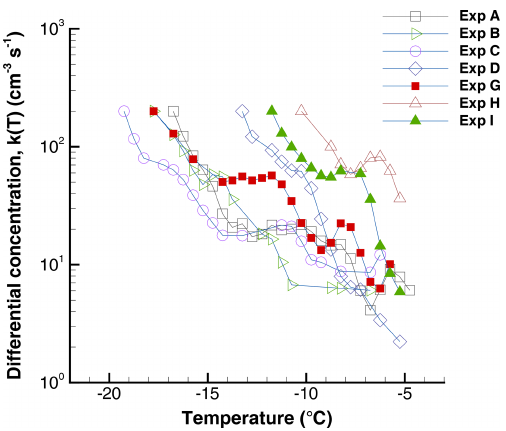
Figure 2. Differential nucleus spectra, K(T ) for the HgI 2 suspen- sions used in the various